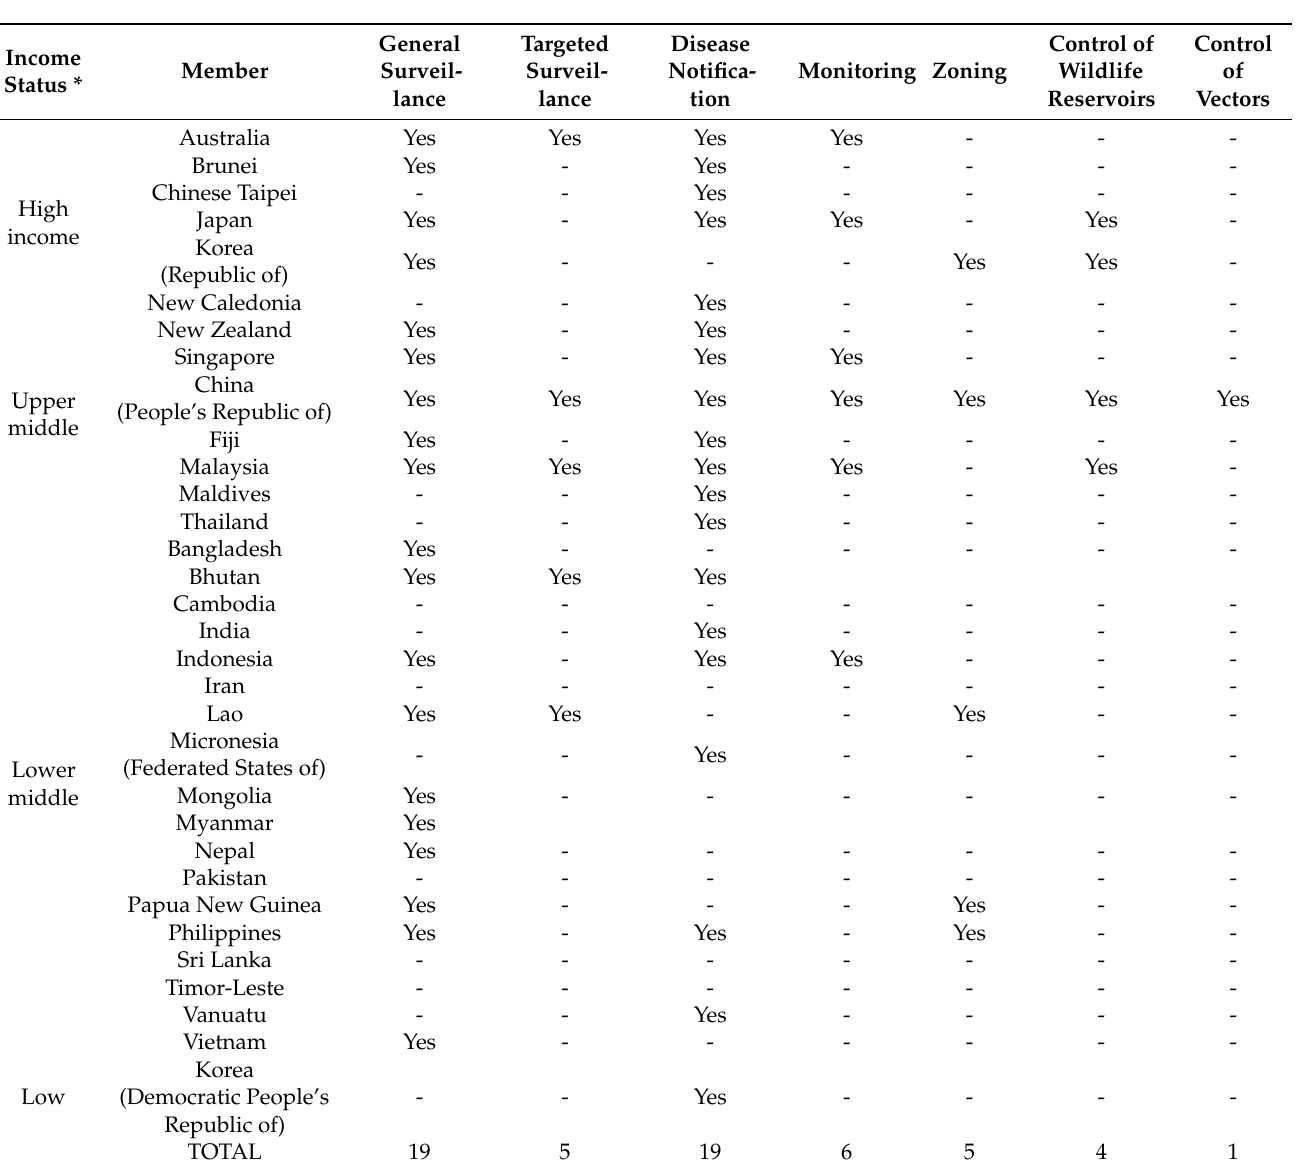
Table 6. Control measures reported in place for ASF in wild suids, per WAHIS [40] reporting and FAO [39], in the Asia Pacific